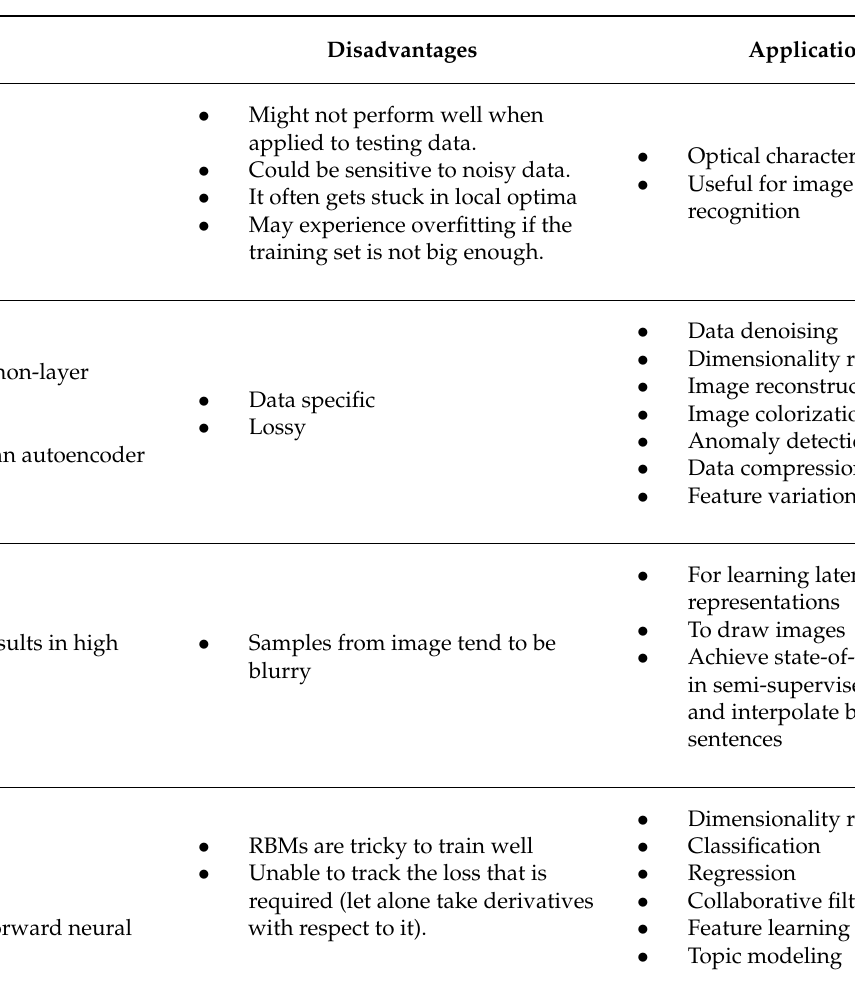
Table 2. Comparison of deep learning algorithms